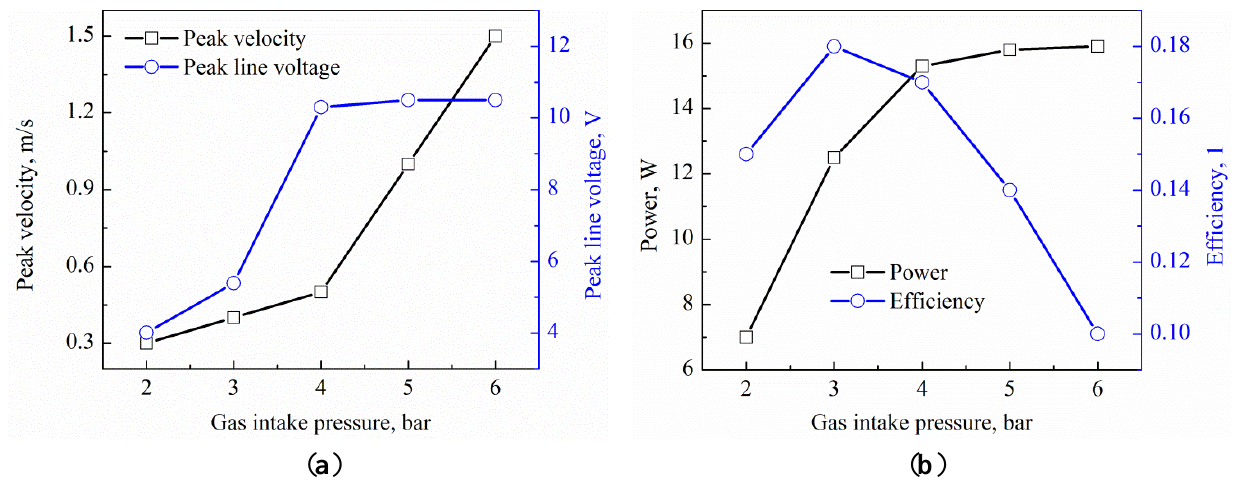
Figure 9. ( a ) 2 bar intake pressure; ( b ) 3 bar intake pressure; ( c ) 4 bar intake pressure; ( d ) 5 bar intake pressure; ( e ) 6 bar intake pressure. At 2 bar, the maximum velocity was less than 0.3 m/s, at 3 bar, less than 0.4 m/s, at 4, 5 and 6 bar, approximately 0.5, 1.0 and 1.5 m/s, respectively.